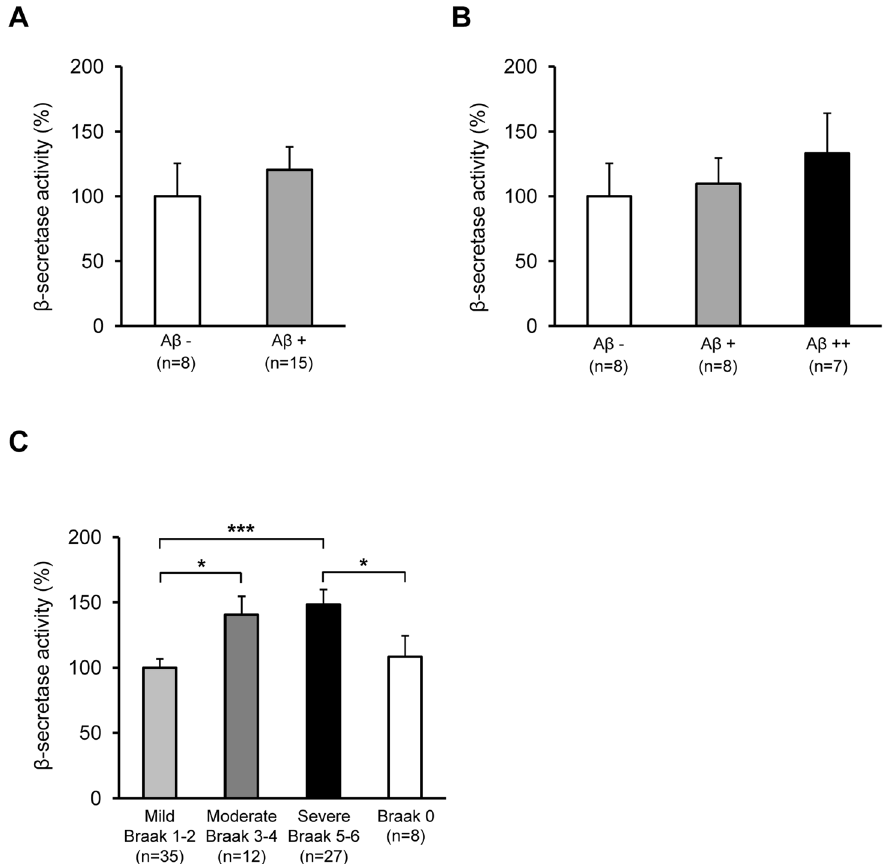
Figure 3. b -secretase activity is unaltered in the frontal cortex of iNPH patients with A b 2 pathology. (A, B) Visual plaque count from immunostained brain sections. (A) A b 2 =no plaques, A b + = plaques observed. (B) A b 2 =no plaques, A b + = less than 100 plaques and A b ++ = more than 100 plaques per section. No significant alteration in b -secretase activity is observed between different iNPH sample groups. (C) b -secretase activity in AD is significantly increased in the inferior temporal cortex of AD patients in relation to disease pathology (Braak 0= subjects without neurofibrillary pathology, 1–2=mild, 3–4=moderate, and 5–6=severe). Mild AD group was normalized to 100%. Data are shown as mean 6 SE, *** p , 0.001, * p , 0.05.